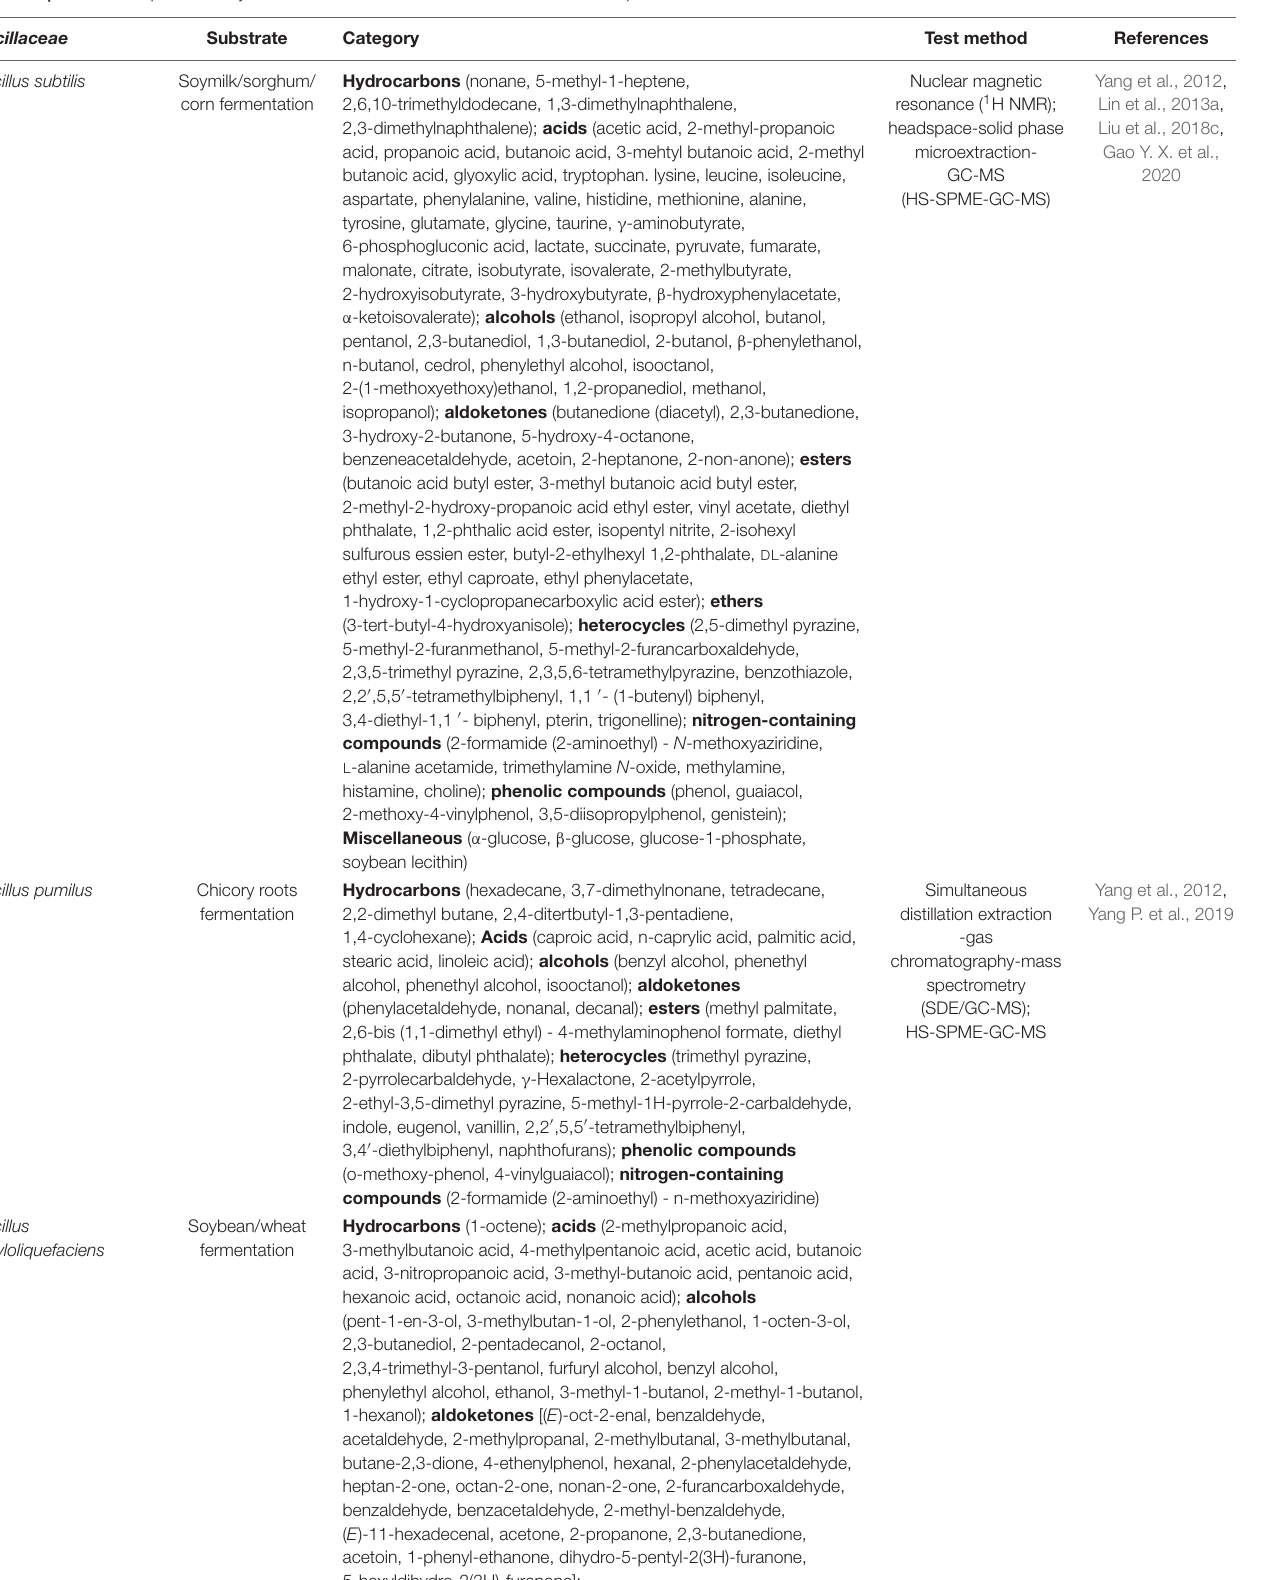
TABLE 2 | Main flavors produced by identified SAB Bacillaceae in various fermentation processes.